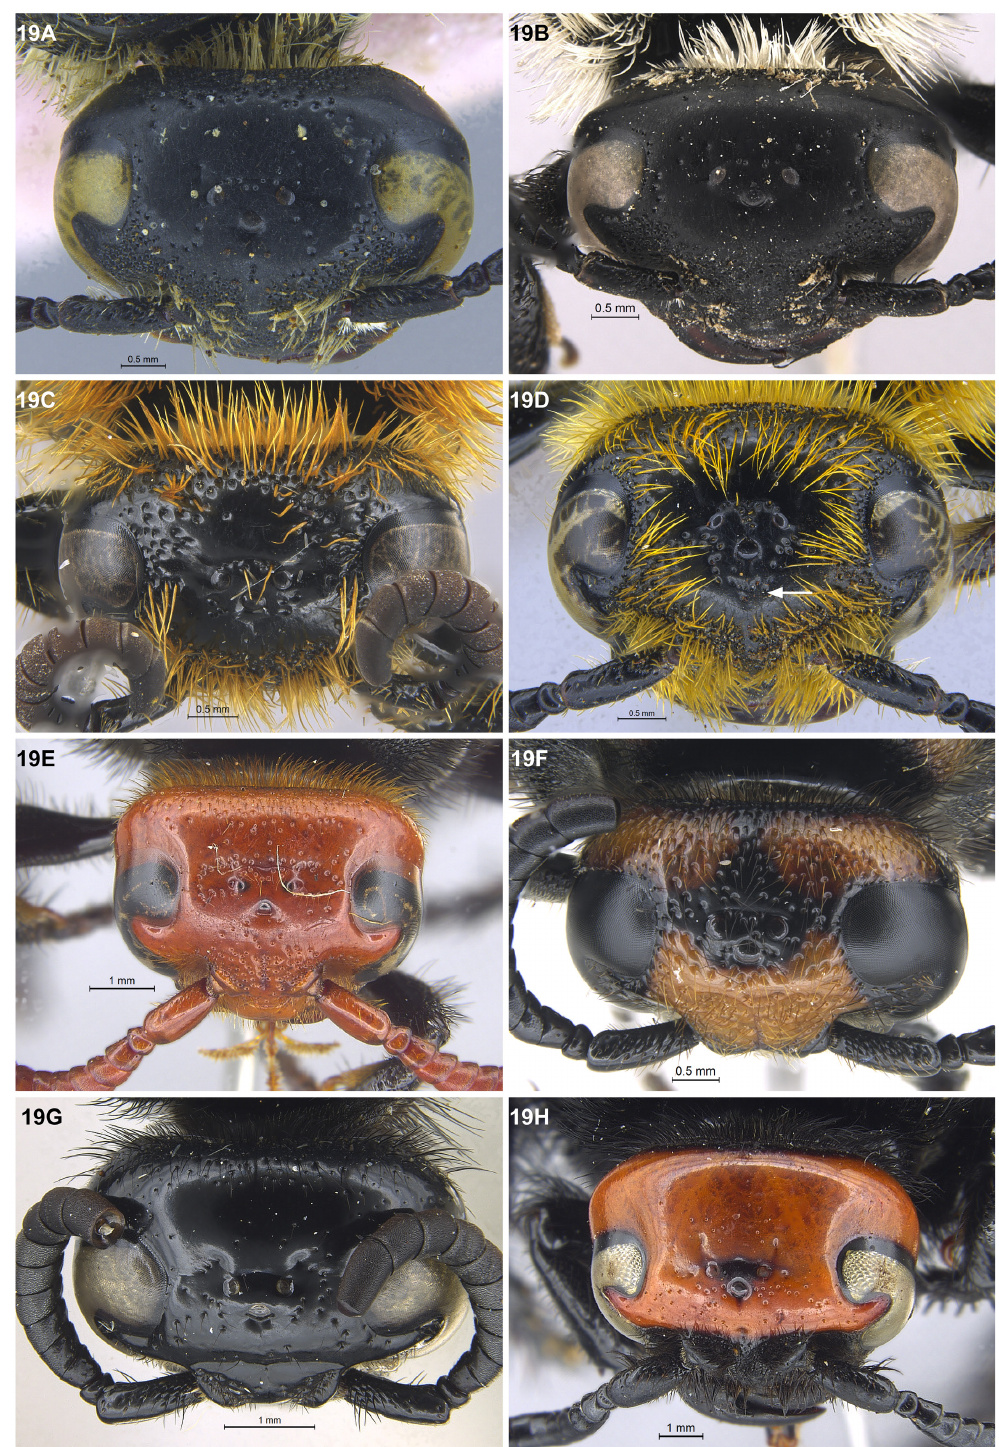
Fig. 19. Females, vertex. A . Campsomeriella annulata annulata (Fabricius, 1793). B . Camps. collaris (Fabricius, 1775) . C . Megacampsomeris formosensis chinensis Betrem, 1941. D . Phalerimeris phalerata phalerata (de Saussure, 1858). E . Austroscolia ruficeps ruficeps (Smith, 1855). F . Carinoscolia junnanensis (Betrem, 1928). G . Liacos erythrosoma (Burmeister, 1854). H . Megascolia azurea (Christ,